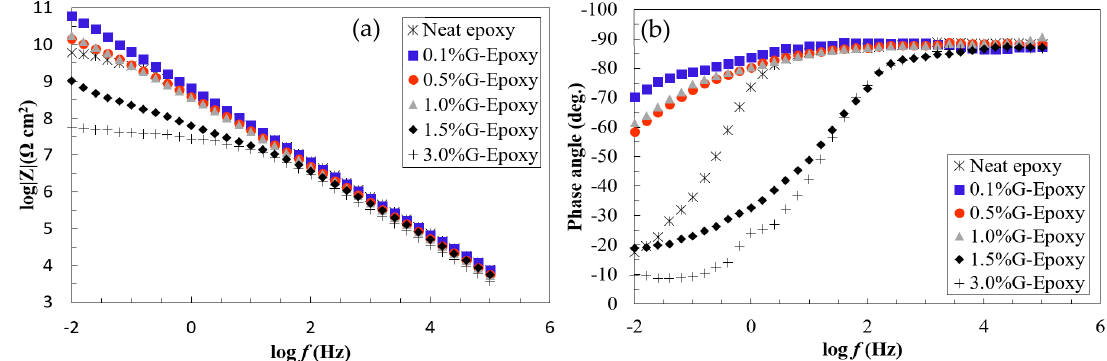
Figure 3. Bode plots in terms of ( a ) impedance and ( b ) phase angle for the test samples.